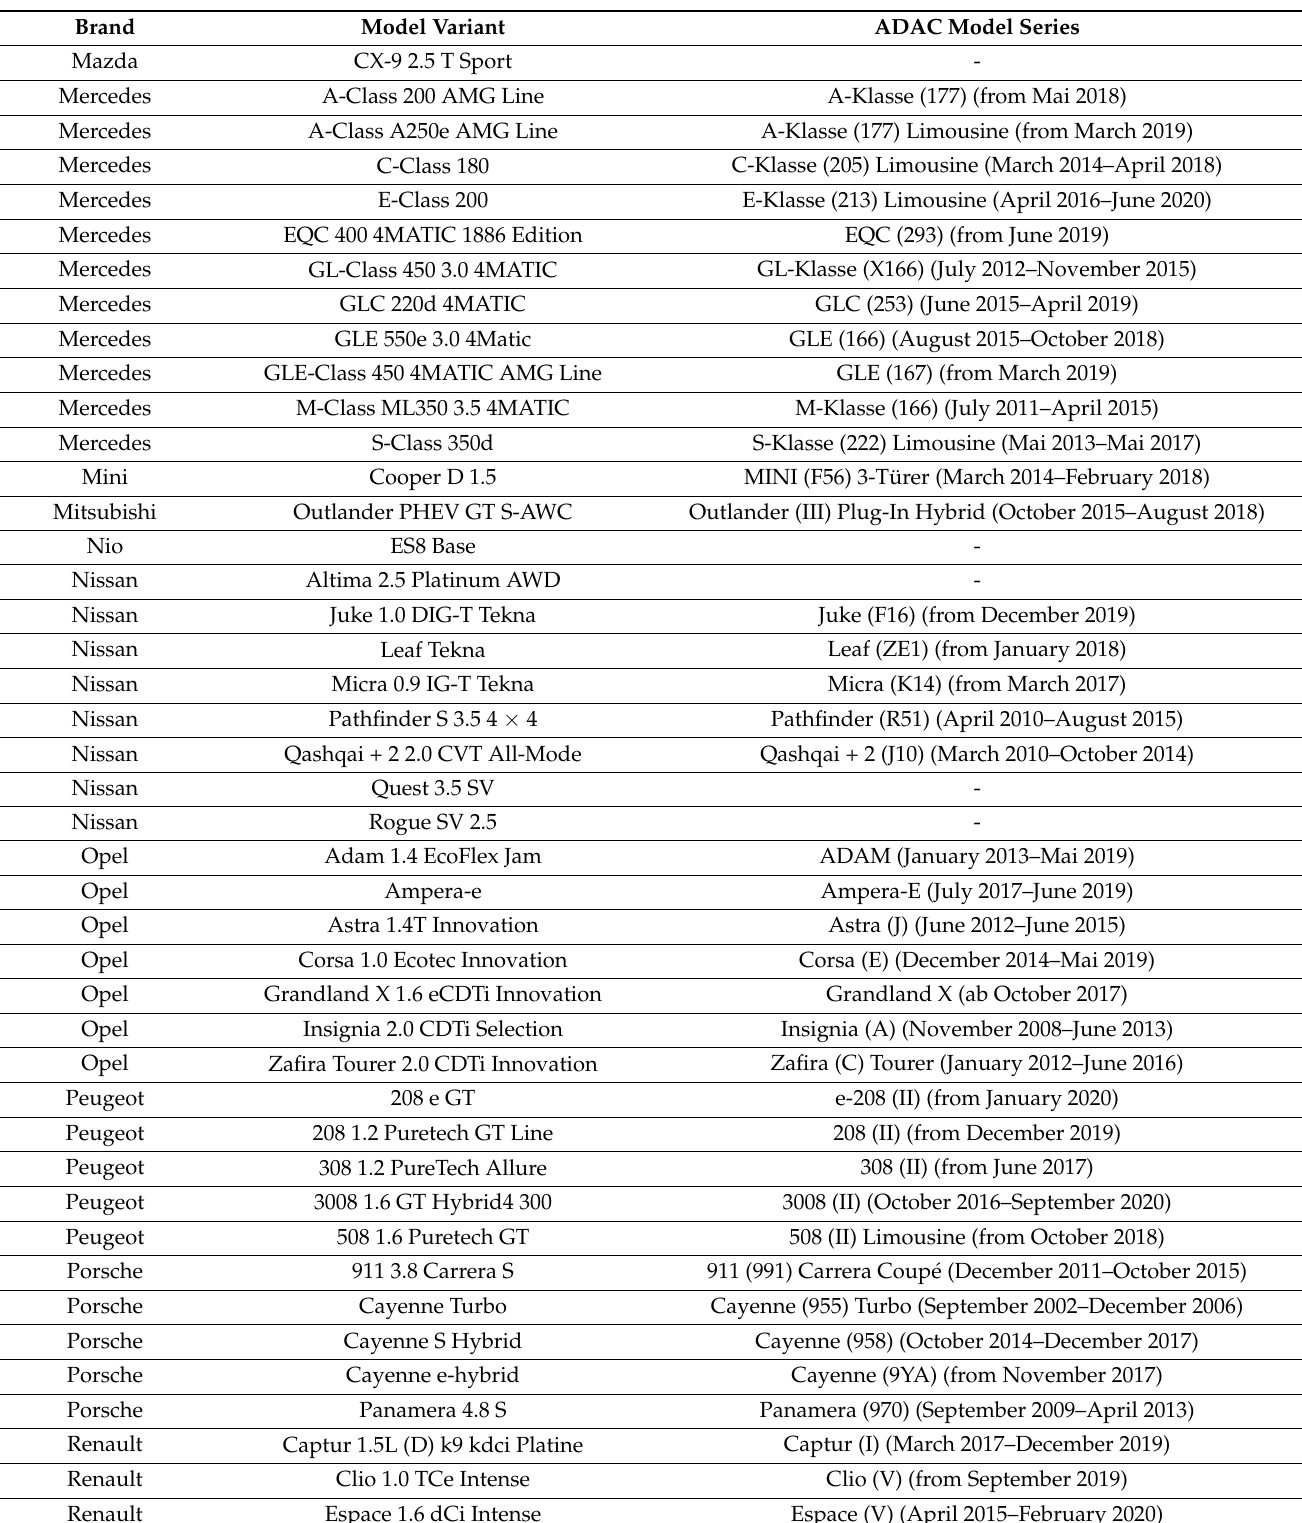
Table A13. Overview of the employed vehicles for the parametric mass model (Part